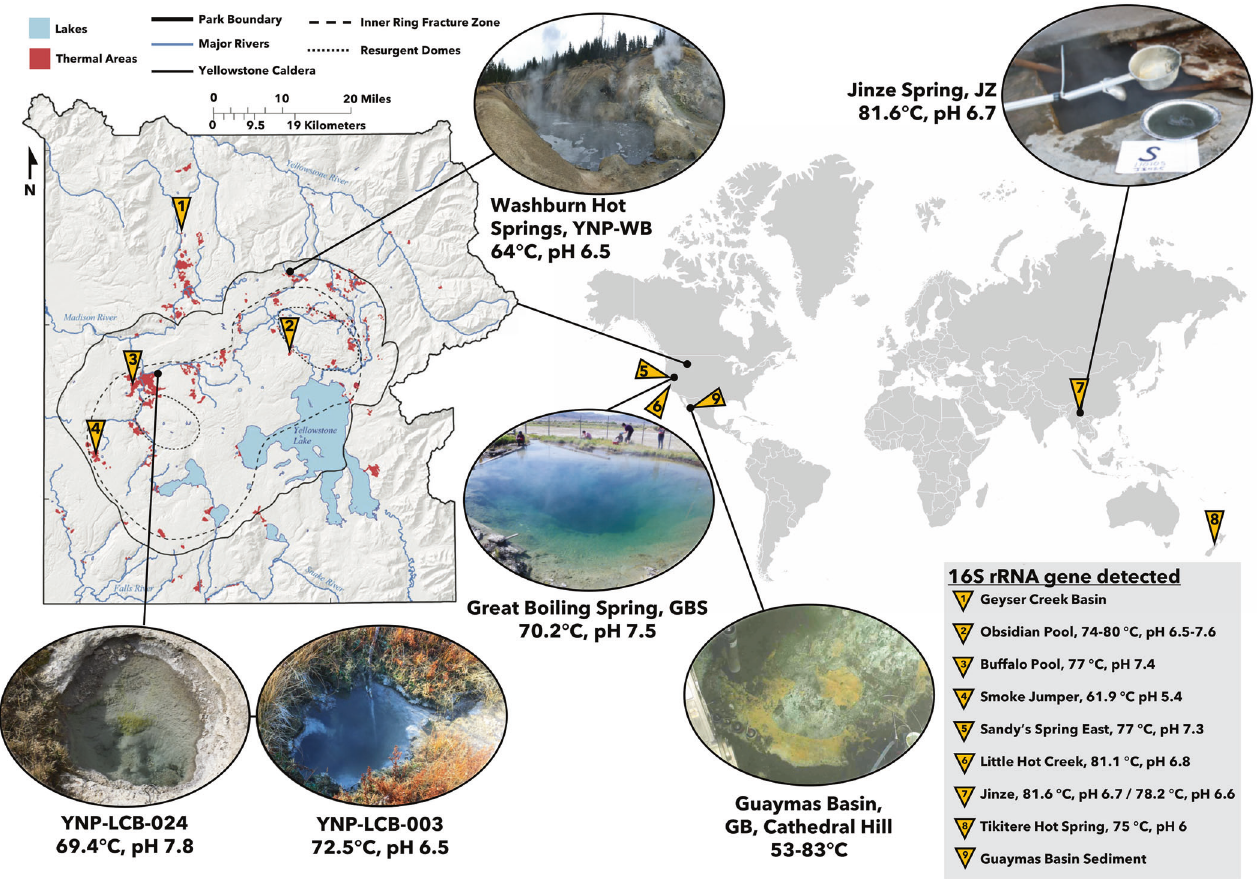
Fig. 2 Biogeography of Culexarchaeia. Sites from where Culexarchaeia MAGs were recovered and where 16S rRNA gene sequences have been detected. A full list of samples and associated metadata can be found in Supplementary File 8. Yellowstone map modi fi ed from ref. [97], GBS picture modi fi ed from ref. [18], and JZ picture modi fi ed from ref. [25]. Guaymas Basin image courtesy of the Woods Hole Oceanographic